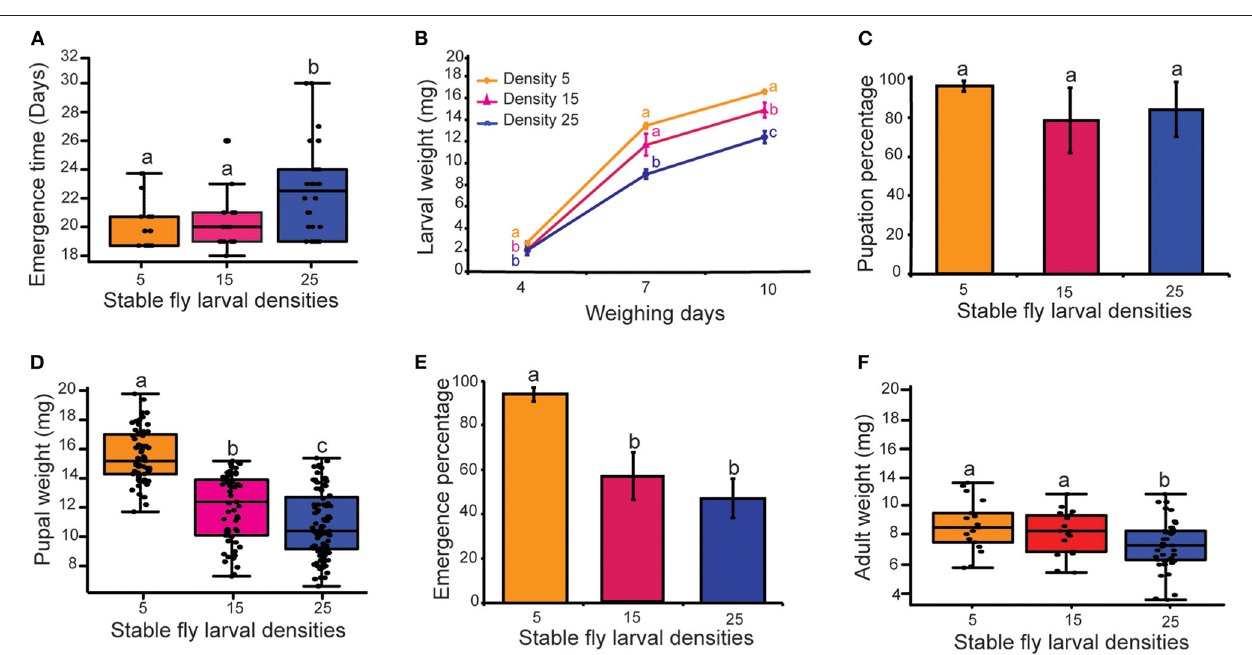
FIGURE 3 | Effect of conspecific larvae density on fitness traits of S. calcitrans . (A) Boxplot showing S. calcitrans emergence time across the different larval densities (Kruskal-Wallis test followed by Dunn’s post-hoc tests, P < 0.05). (B) Line graph illustrating the change of S. calcitrans larvae weight across the different larval densities after 4 days (ANOVA test followed by SNK’s post-hoc test, P < 0.05), 7 days (Kruskal-Wallis test followed by Dunn’s post-hoc test, P < 0.05) and 10 days (ANOVA test followed by SNK’s post-hoc test, P < 0.05) of eclosion. (C) Bar charts depicting the mean percentage of S. calcitrans larvae reaching the pupal stage across the different larval densities (GLM with binomial distribution followed by Tukey post-hoc mean separation test, P < 0.05, n = 10). (D) Boxplot showing S. calcitrans pupal weight across the different larval densities (Kruskal-Wallis test followed by Dunn’s post-hoc test, P < 0.05). (E) Bar chart illustrating the mean percentage of S. calcitrans emerging as adults from the pupal stage across the different larval densities (GLM with binomial distribution followed by Tukey post-hoc mean separation test, P < 0.05, n = 10). (F) Boxplot depicting S. calcitrans adult weight across the different larval densities (ANOVA test followed by DTK’s post-hoc test, P < 0.05). On each boxplot, the minimum and maximum values of all the data are represented by the ends of boxplot whiskers. On the line graph and bar charts, error bars indicate the standard error of the mean. Treatments with different lowercase letters are significantly different from each other.